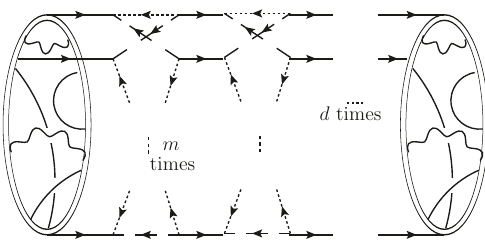
Figure 4 . Diagrams contributing with transcendentality ζ d at finite N and generic values of the couplings.